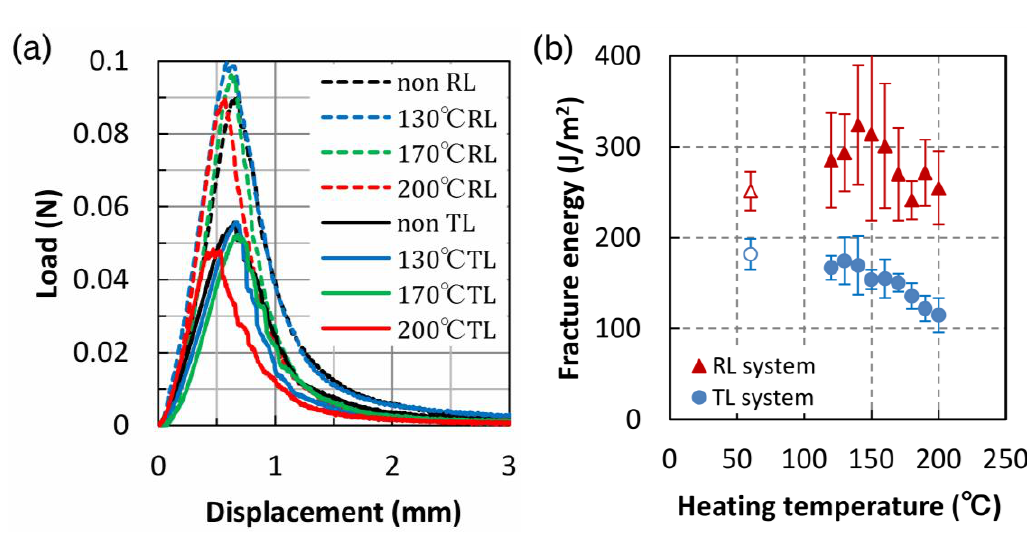
Figure 2. Changes in fracture energy: ( a ) load–displacement curves in single-end notched bending test and ( b ) fracture energy dependence on heating